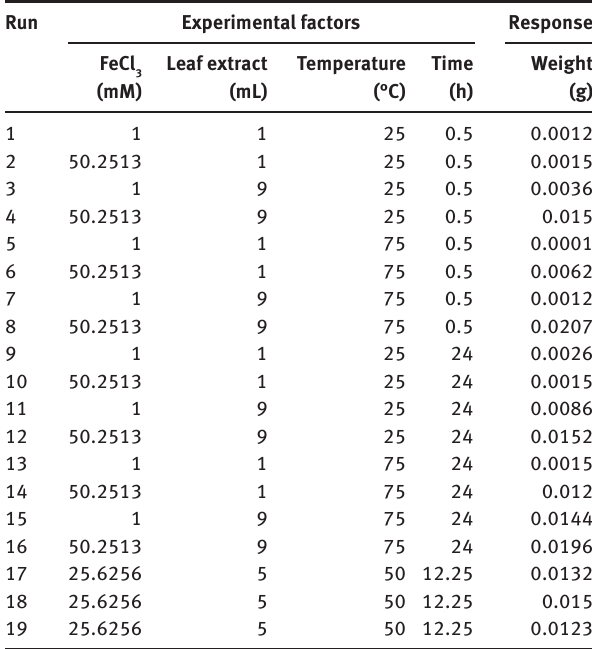
Table 1: Experimental design and results of screening factors affecting green synthesis of INPs.